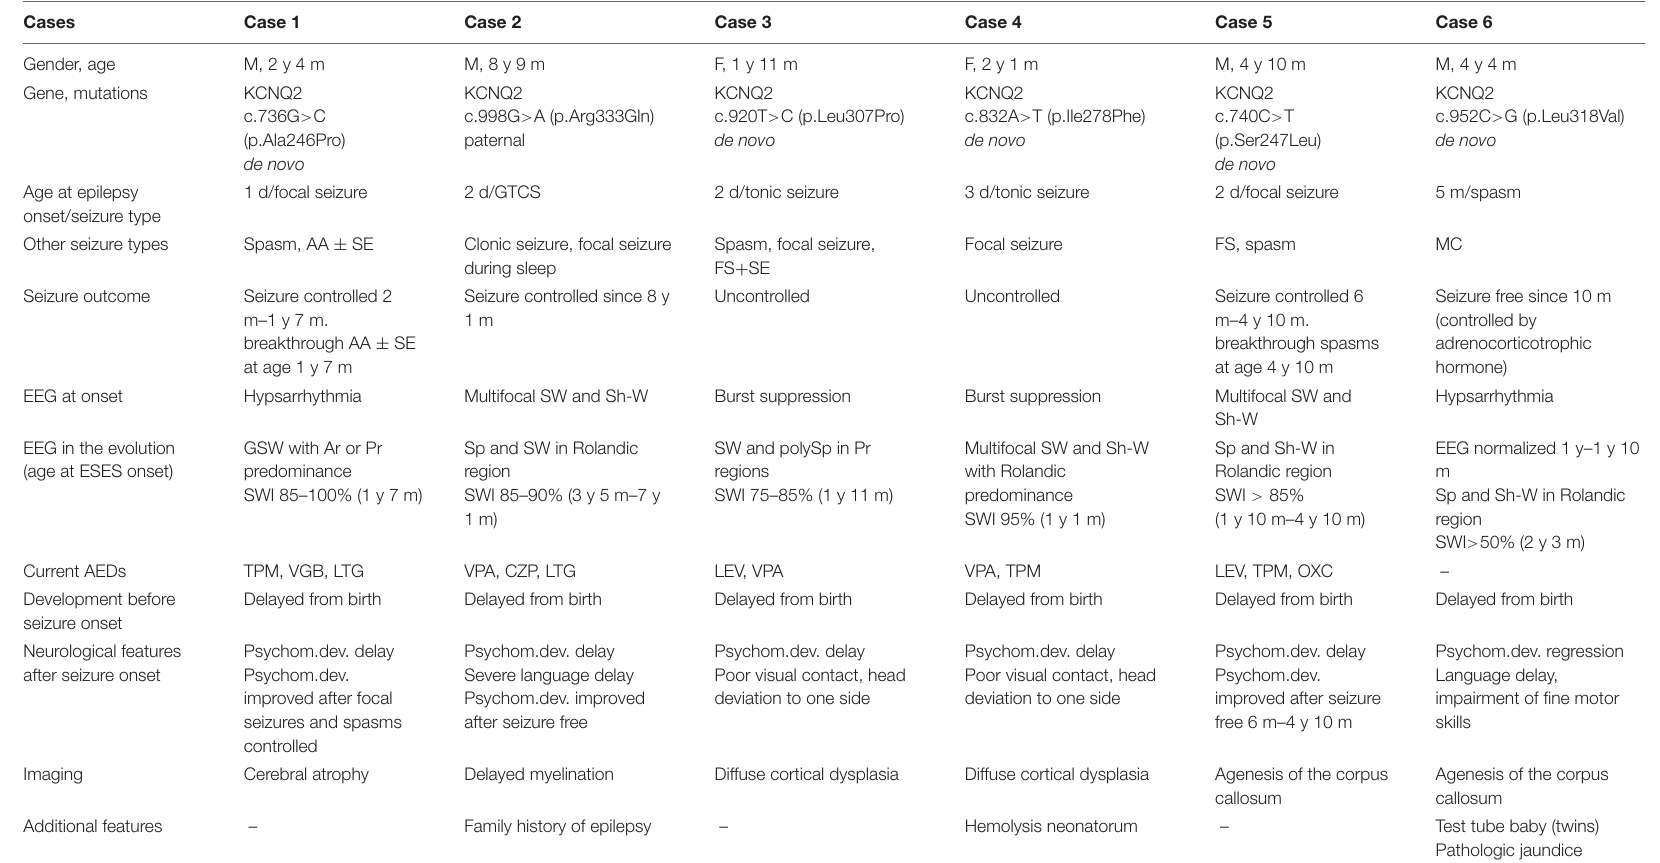
TABLE 2 | Clinical characteristics of 17 cases of genetic DEE/EE with ESES.